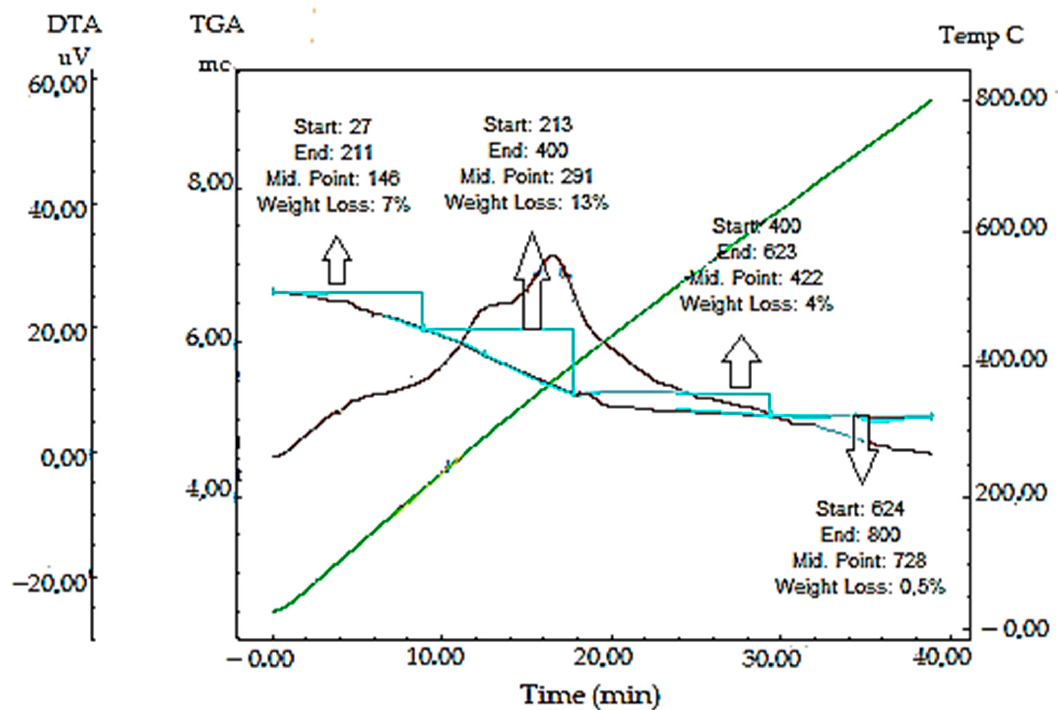
Figure 9. Mass loss points that occurred in the TGA-DTA data of synthesized AuNPs during temperature changes.